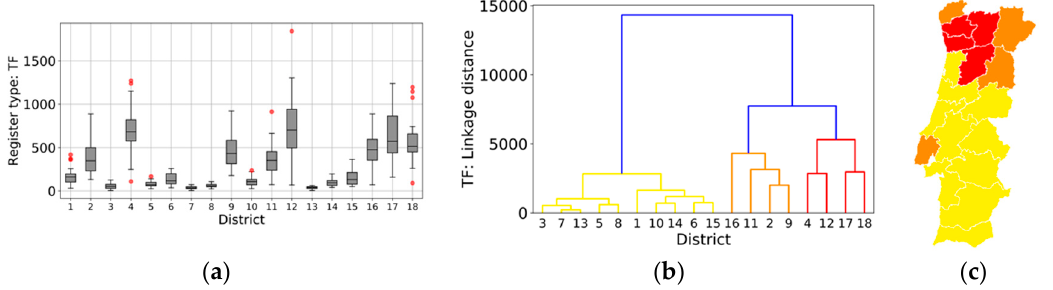
Figure 6. Spatial distribution of Total forest fires with burned area greater than 1 ha (TF): ( a ) Distribution by district; ( b ) Clusters by annual profile of distribution; ( c ) Clusters in geographic location (cophenetic coefficient: 0.85).